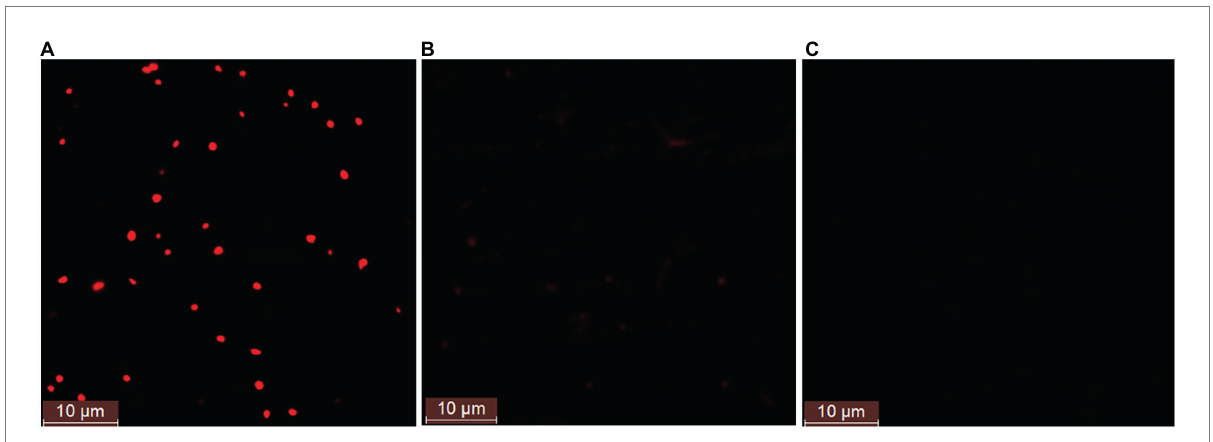
FIGURE 2 The fluorescence microscope examination of the Nile red stained cells in the fermented SE medium with the inoculation of strain H. mediterranei ATCC 33500 (A) or without (B) . The PHA-defeated strain Haloferax mediterranei ∆ pyrF Δ EC (C) was used as a negative control to preliminarily determine the accumulation of PHA observed under